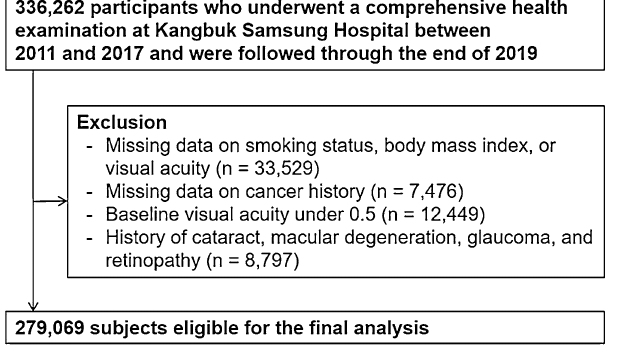
Figure 1. Flow diagram for the selection of the study